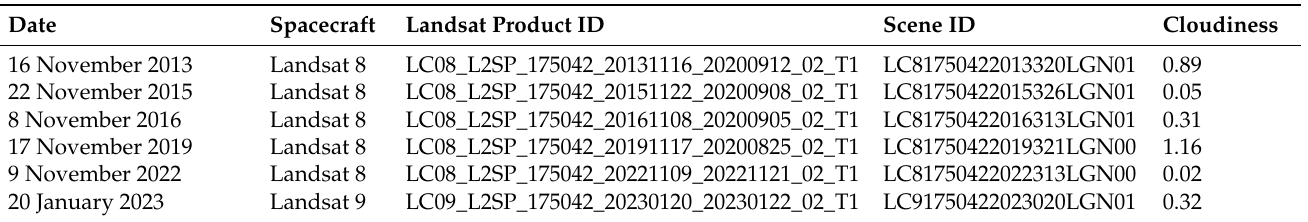
Table 1. Satellite images used for computing the VIs: Landsat-8 OLI/TIRS collected from the USGS 1